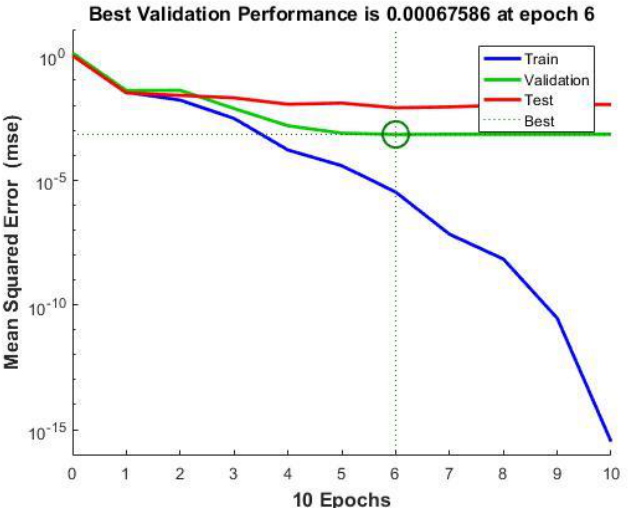
Figure 3. The mean squared error (MSE) of the optimum classifier model.